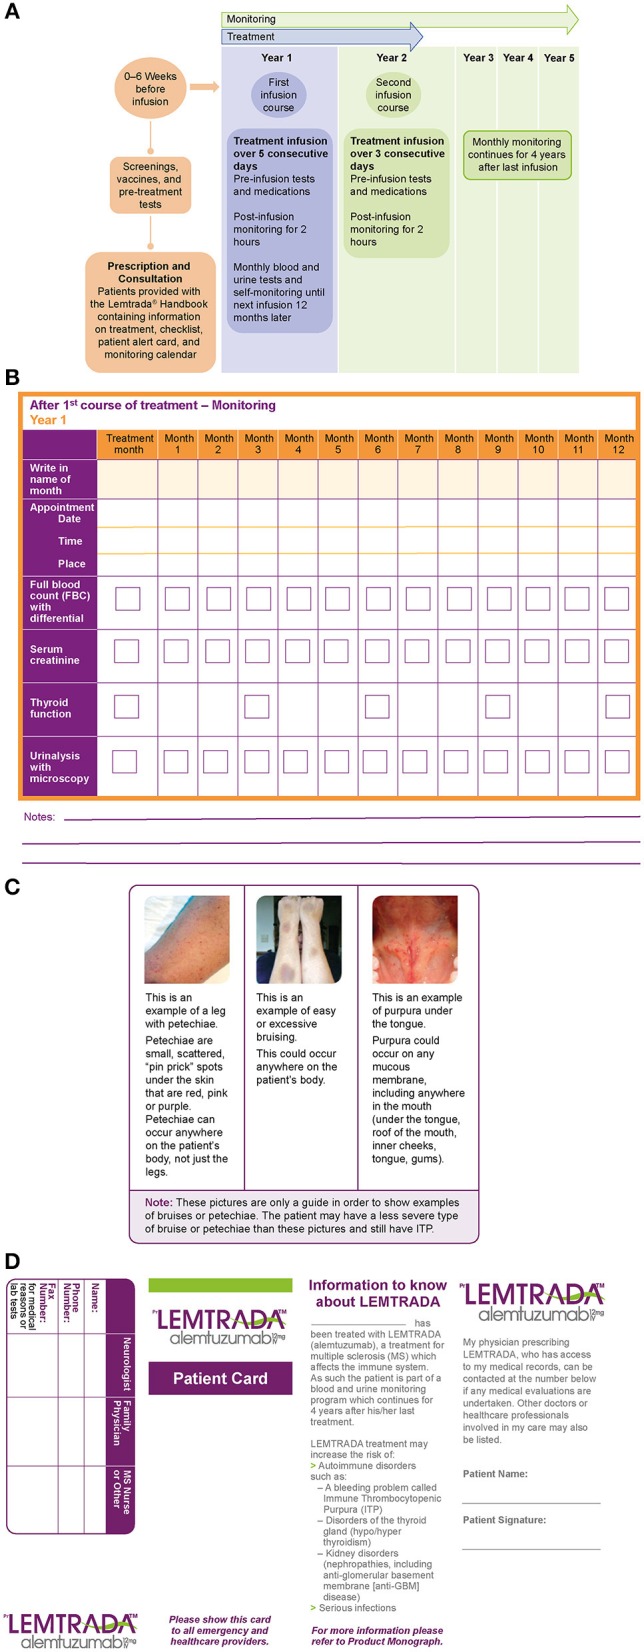
(A) Alemtuzumab dosing regimen and monitoring, (B) patient monitoring calendar, (C) patient reference guide with examples of immune thrombocytopenia (ITP) skin conditions, and (D) patient alert card.